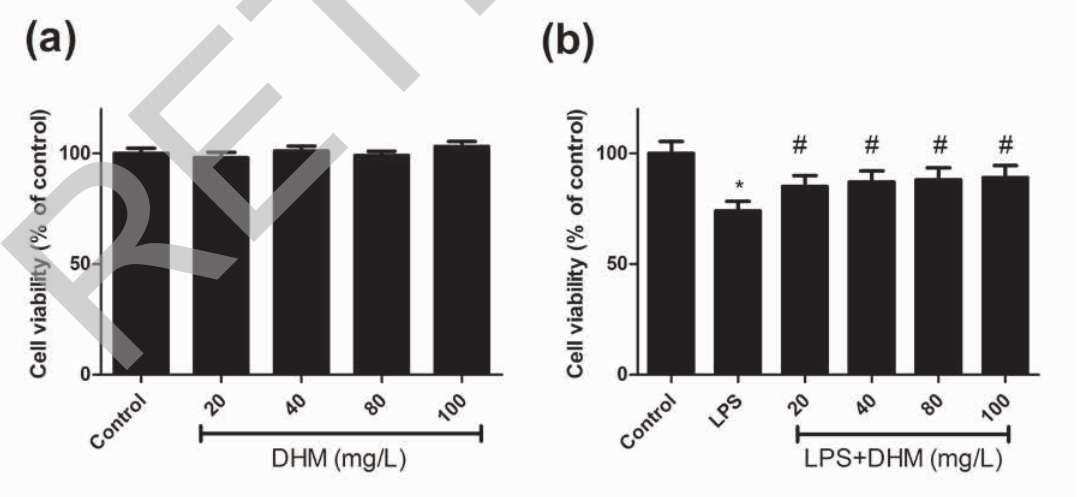
Figure 1: The effects of various concentrations of DHM (20, 40, 80 or 100mg/L) on the viability of BV-2 microglial cells using the MTT assay. (a) DHM did not exhibit cytotoxicity on BV-2 microglial cells; (b) DHM (20, 40, 80 or 100mg/L) significantly suppressed the LPS-induced viability reduction of BV-2 microglial cells. *P<0.01 compared with control group; #P<0.01 compared with LPS